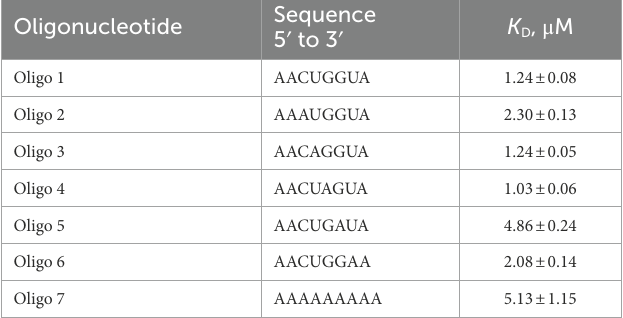
TABLE 1 Equilibrium dissociation constants of the CspA:RNA oligonucleotide complexes determined by tryptophane fluorescence